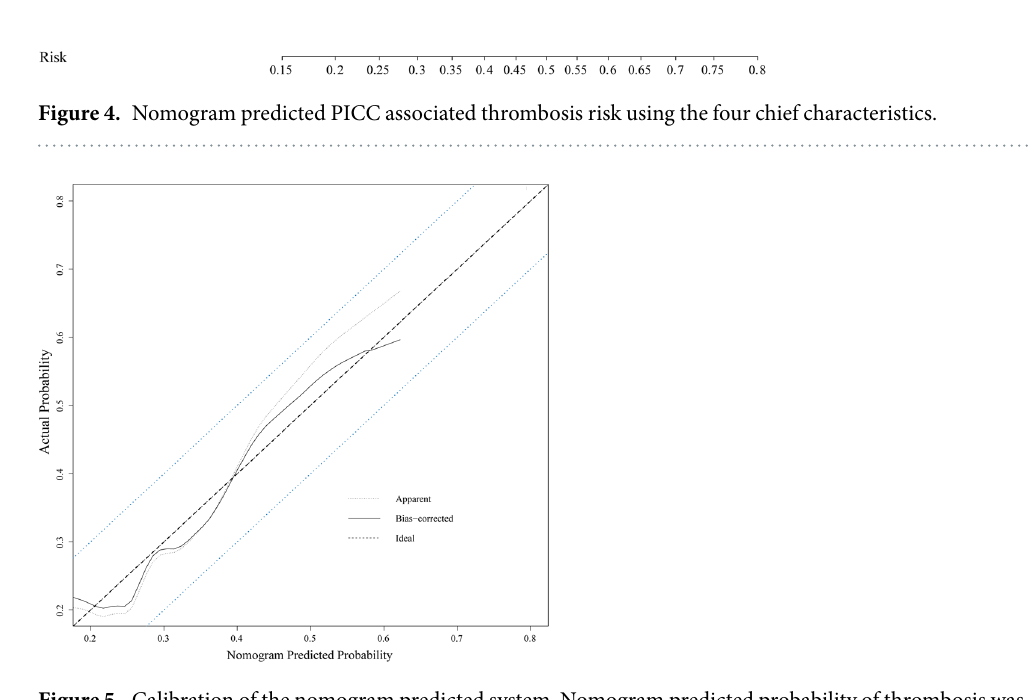
Figure 5. Calibration of the nomogram predicted system. Nomogram predicted probability of thrombosis was plotted on the x-axis, actual PICC associated thrombosis was plotted on the y-axis and 95% CIs measured by logistic regression analysis. All predictions lie within the 10% margin of error (within the blue dots